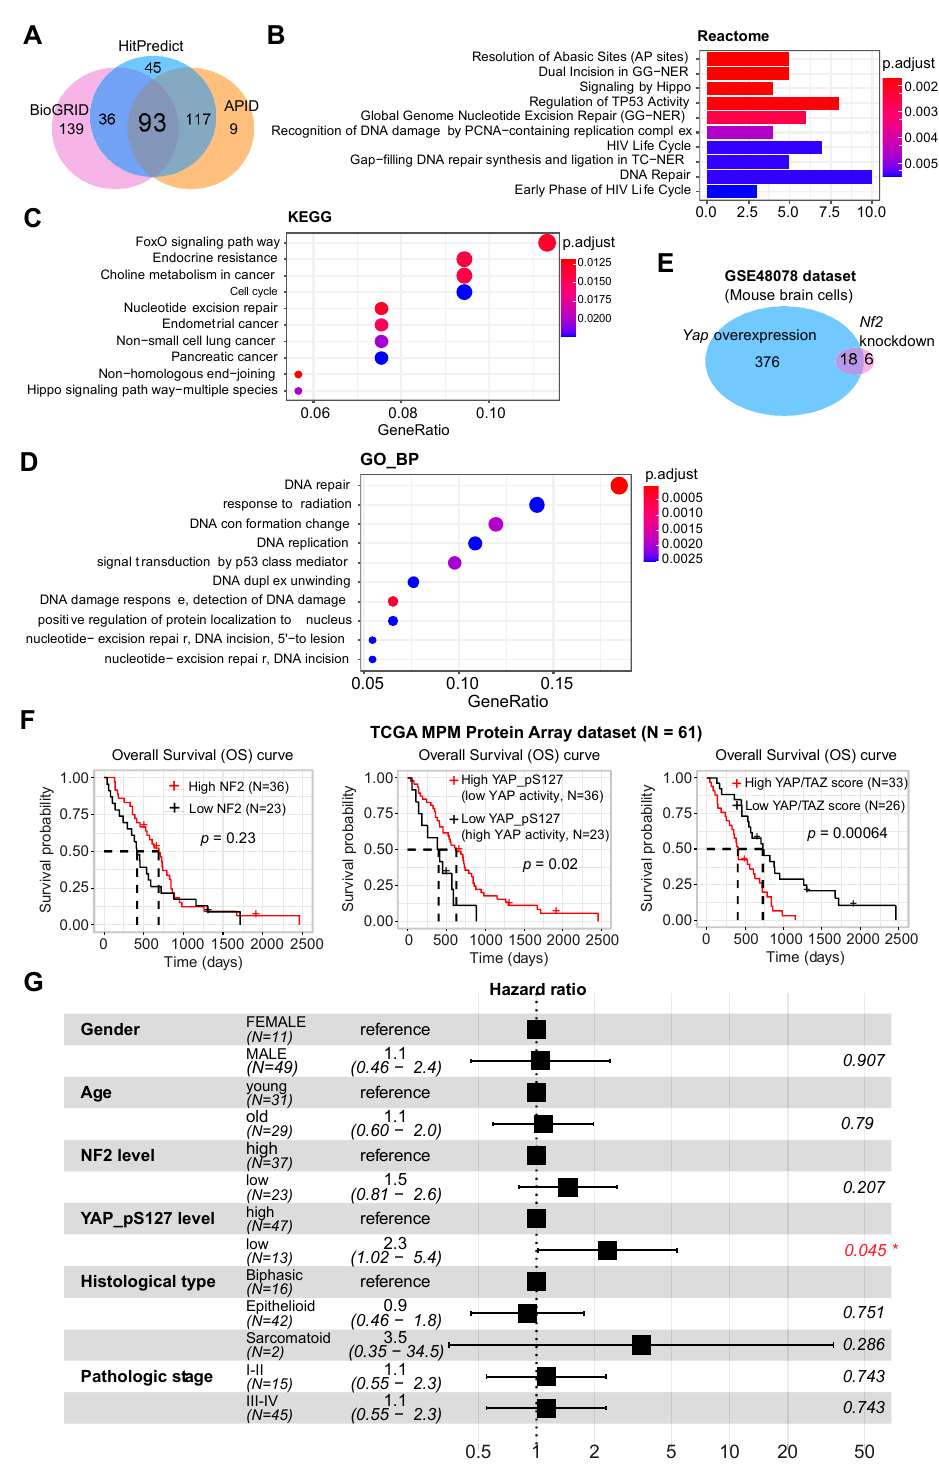
Figure 6. A pleiotropic role of NF2. ( A ) The common ( N = 93) physical interactors of NF2 based on 3 curated public databases (BioGRID, HitPredict, and APID). ( B – D ) Top 10 significantly enriched Reactome ( B ), Kyoto Encyclopedia of Genes and Genomes (KEGG) ( C ), and Gene Ontology (GO; biological process [BP]) ( D ) pathways based on the common interactors ( N = 93) of NF2 in ( A ). ( E ) Venn plot showing the gene changes in mouse brain cells with Yap1 overexpression and Nf2 knockout. Data were downloaded from GSE48078. ( F ) Association of NF2, phospho ‐ YAP (S127), YAP/TAZ score with overall survival in MPM patients. ( G ) Univariate ( A ) and multivariate ( B ) survival analysis showing that YAP/TAZ score and the protein level of p ‐ YAP (S127) but not NF2 predict prognosis of MPM